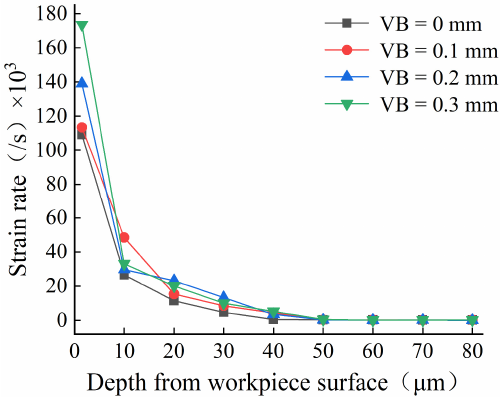
Figure 6. Plastic strain through the depth of workpiece surface.